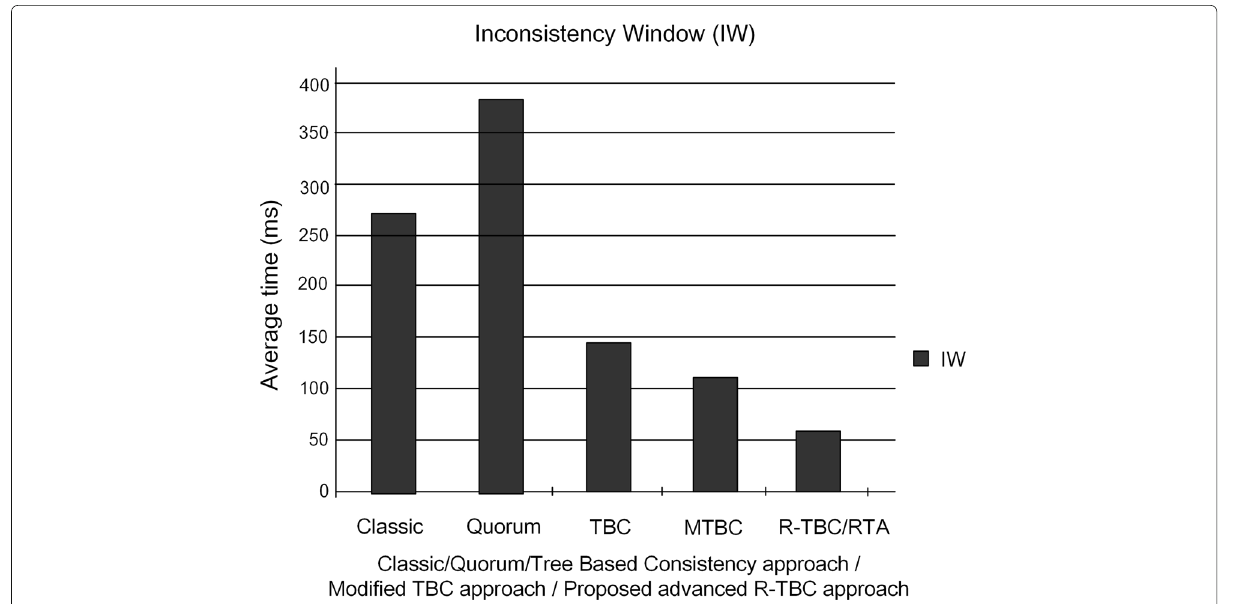
Fig. 15 Comparison of standard approaches (Classic, Quorum, TBC/MTBC) and proposed advanced R-TBC/RTA approach relating Inconsistency Window